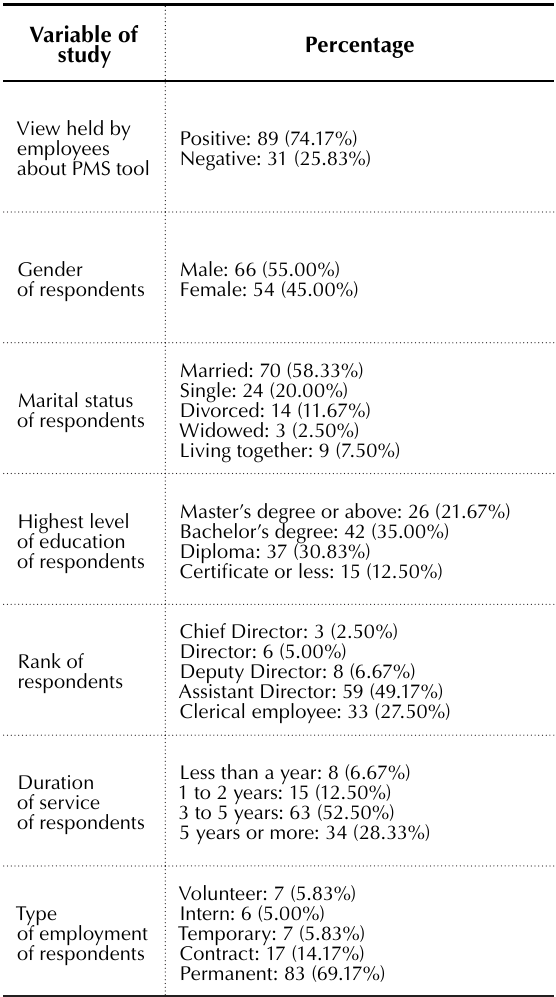
Table 1. General characteristics of